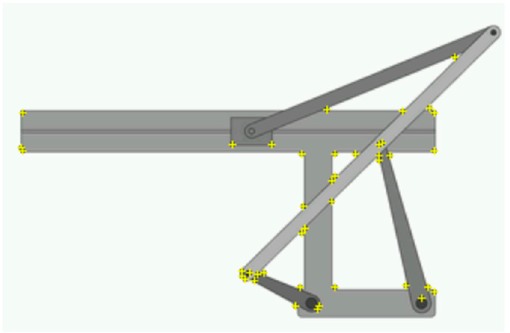
Figure 4. The feature point detected in Vuforia Target Manager for the image of the crank-slider